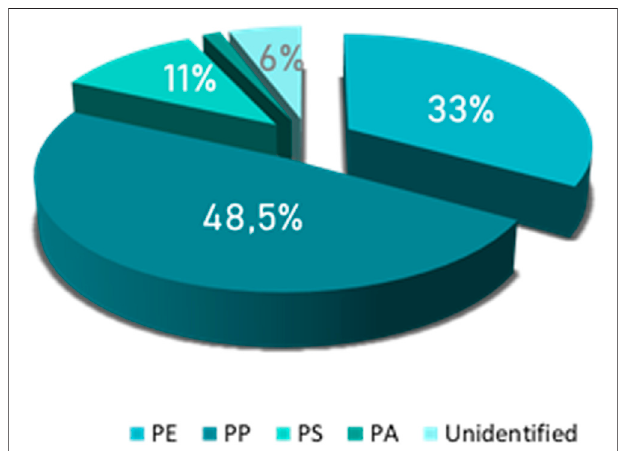
FIGURE 10 | Percentages of identi fi ed polymers distributed in the Lebanese coastal waters.